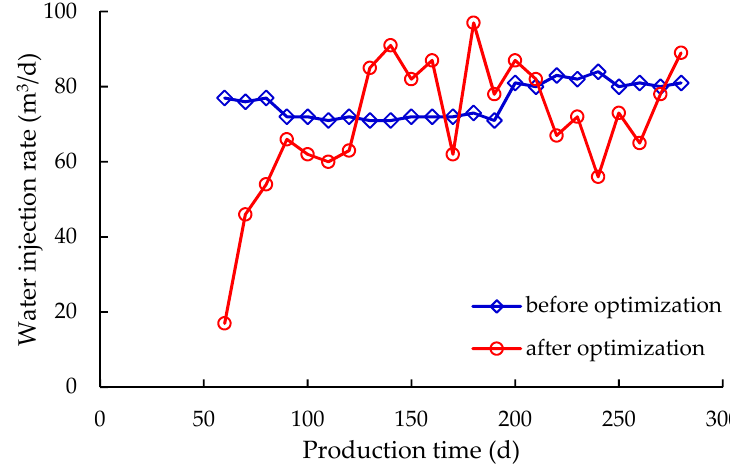
Figure 8. Distribution of water injection rate obtained by waterflood optimization.